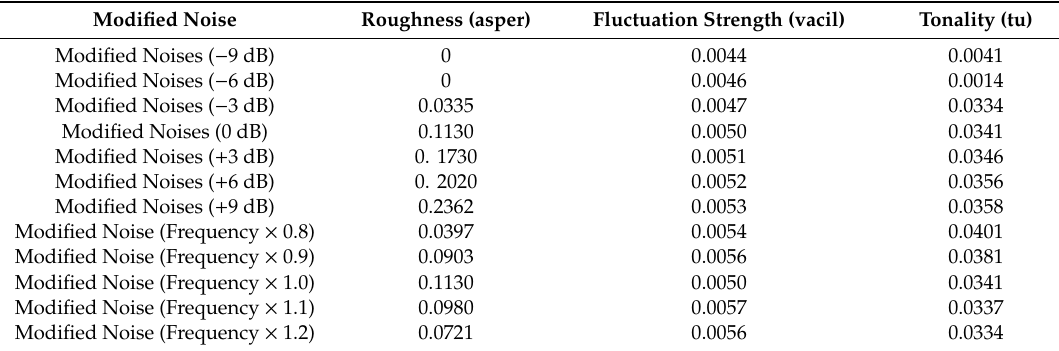
Table 8. Roughness of modified churn noises.